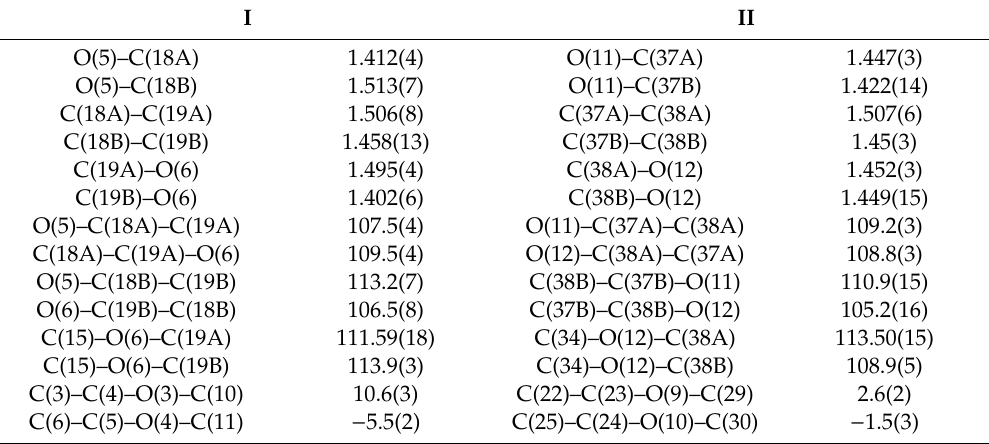
Table 2. Selected bond lengths (Å) and bond angles ( ◦ ) in the distorted regions of crystal 5IA , 5IB , 5IIA and 5IIB , which show distinctive discrepancy. Torsional angles ( ◦ ) were shown for the di ff erence in the methoxy group substitutions.